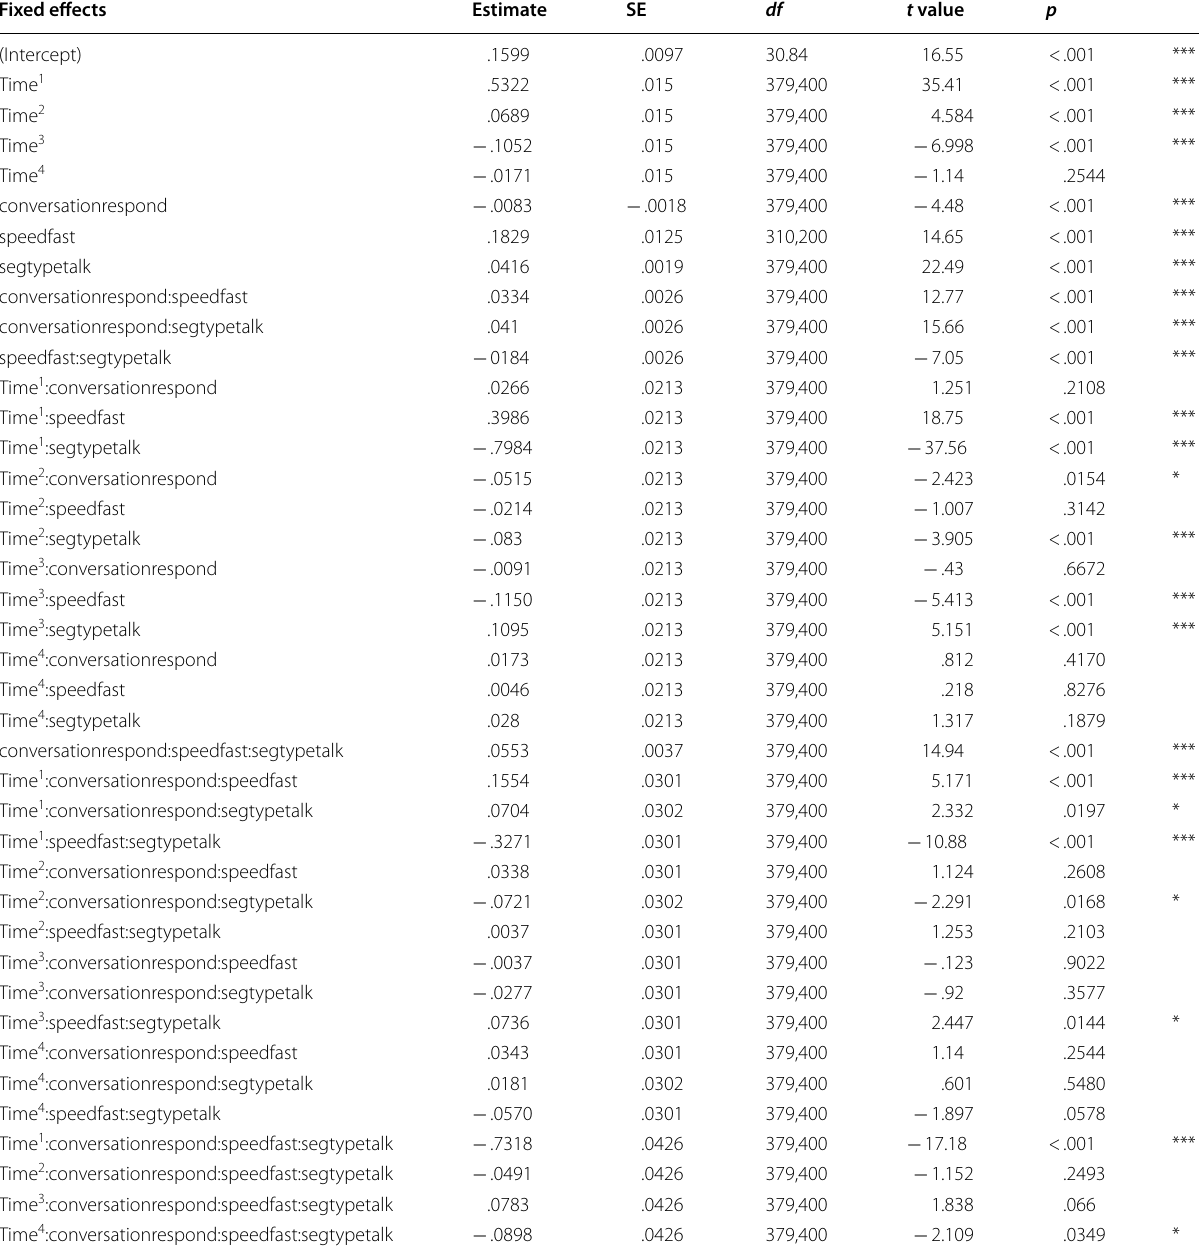
Table 5 Quartic model coefficients in E2 Fixed